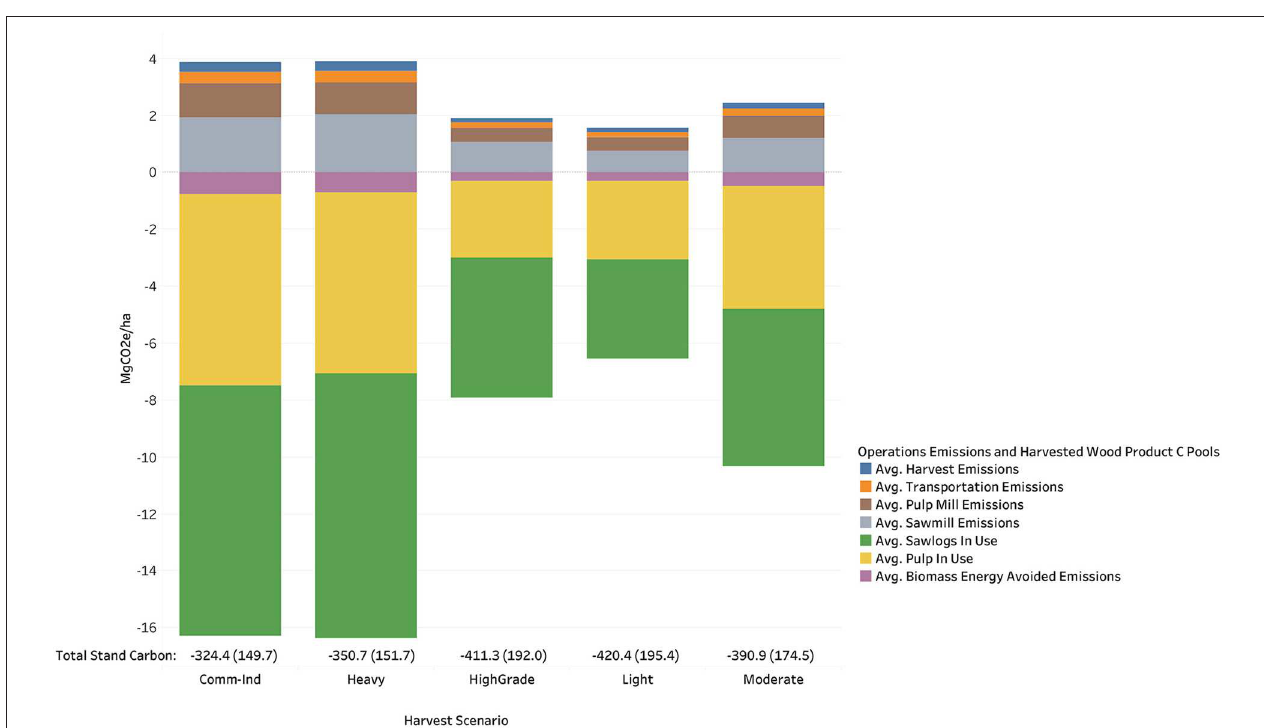
FIGURE 3 | Post-harvest C pools at year 0 for each harvest scenario and risk category ( n = 4926 for each scenario). Positive values denote C emissions, negative values denote C sequestered. Total stand carbon is presented as the mean value with SD in brackets and includes the following pools calculated in FVS: live trees (including stems, branches, and foliage, but not including roots), belowground live (the roots of live trees), belowground dead (the roots of dead and cut trees), standing dead (dead trees, including stems, and any branches, and foliage still present, but not including roots), forest down dead wood (all woody material, regardless of size), forest floor (litter and duff), and herbs and shrubs. Note: soil carbon is not included in this value since FIA data do not include this parameter.